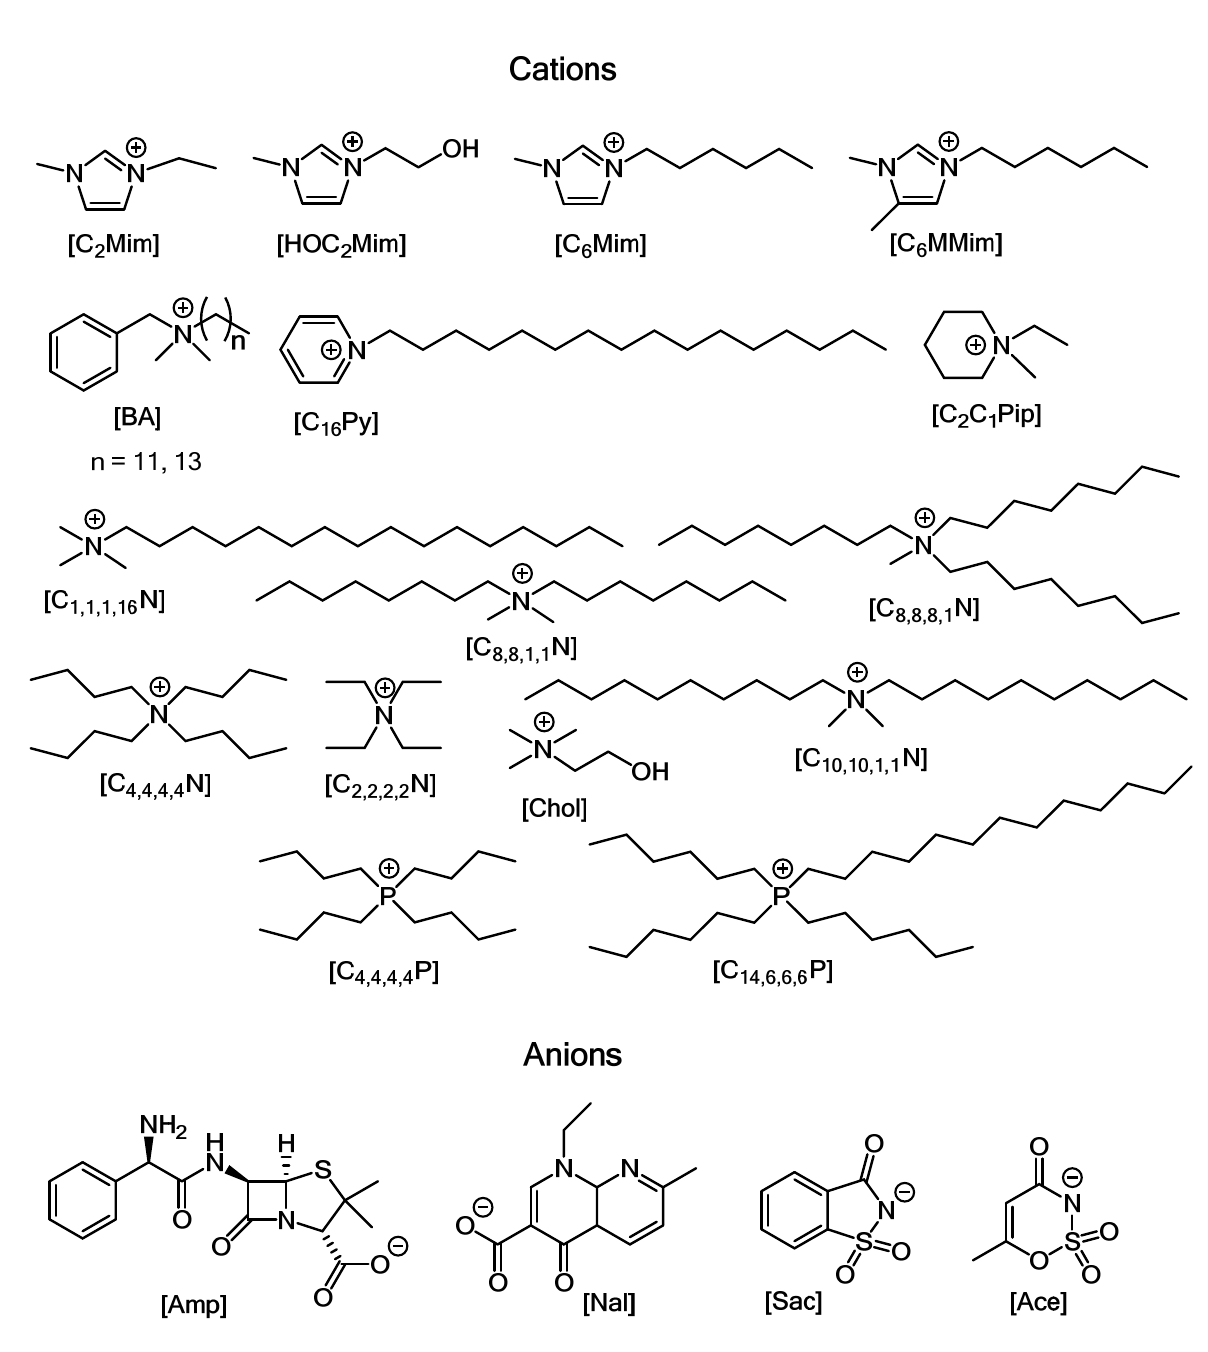
Figure 19. Cations and anions used in antimicrobial API-ILs .